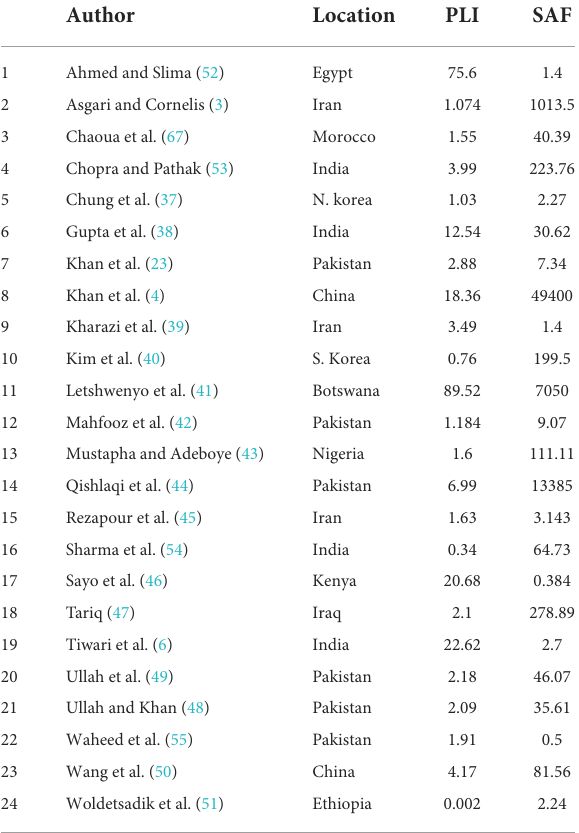
TABLE 3 Lead load index and soil lead accumulation